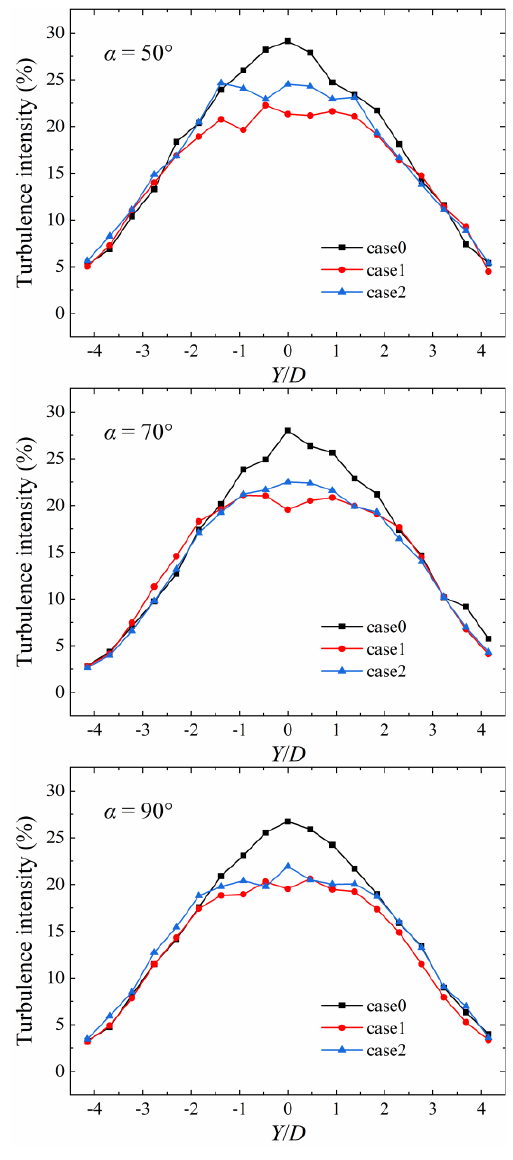
Figure 8. Turbulence intensity distribution at X / B = 8.48.